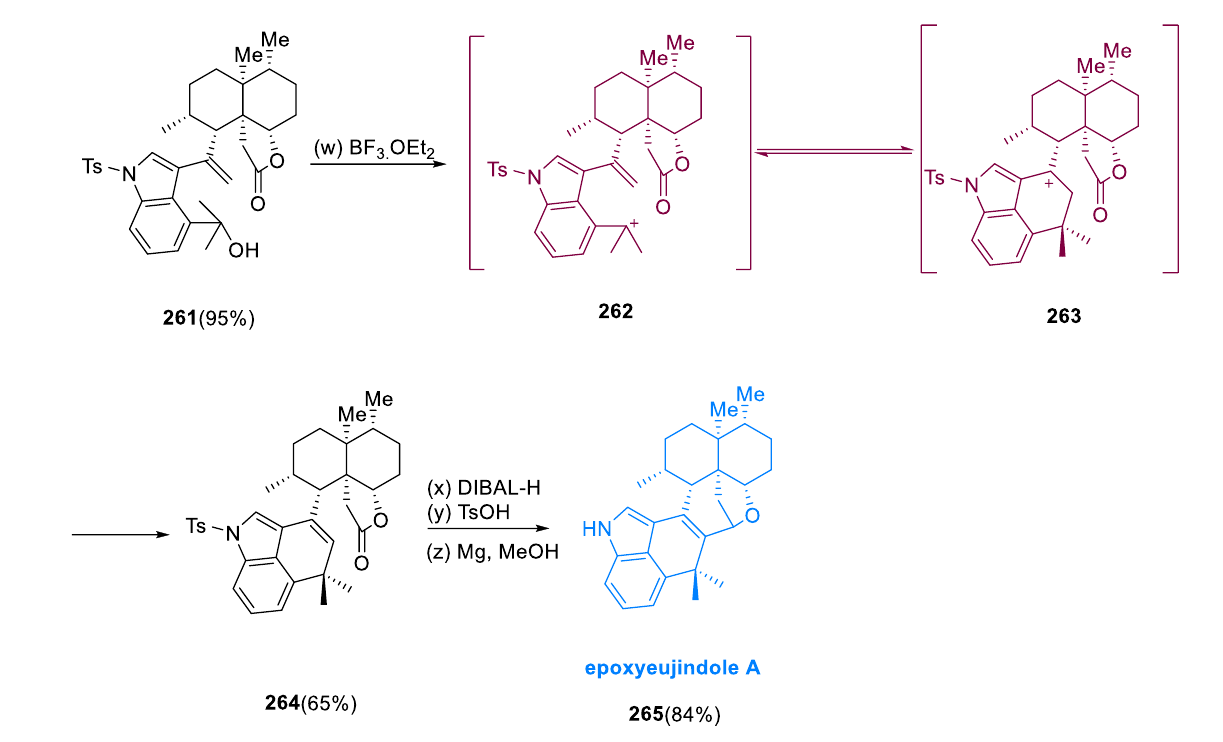
Scheme 19. Total synthesis of epoxyeujindole